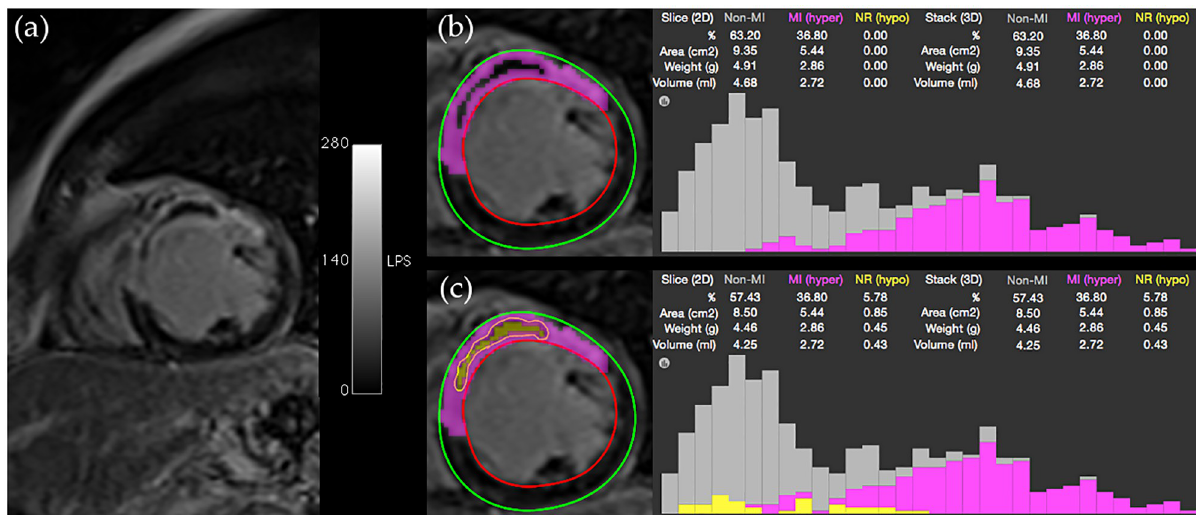
Fig 3. CMRSegTools segmentation output. (a) Image viewer before executing CMRSegTools; (b) Epicardium and endocardium contours from the myocardial segmentation, lesion segmentation (pixels in magenta colour), histogram and quantification statistics without MVO region; (c) Segmented regions, histogram and quantification statistics after defining the MVO region (contour and pixels in yellow colour).